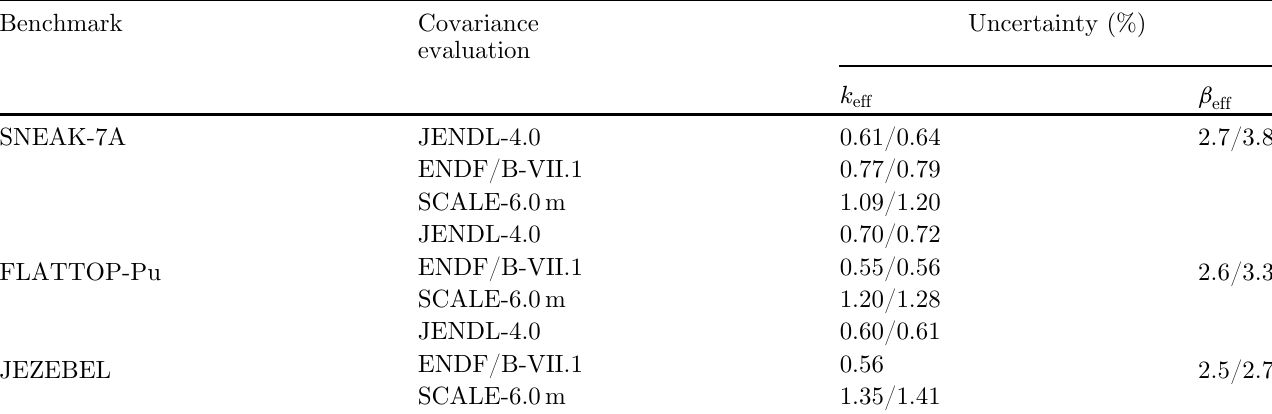
Table 1. Uncertainties in k and b calculated using the SUSD3D code. The two values for the b eff eff correspond to the assumption of no/full correlation among the n d uncertainties of different actinides. SAD/SED uncertainties are not